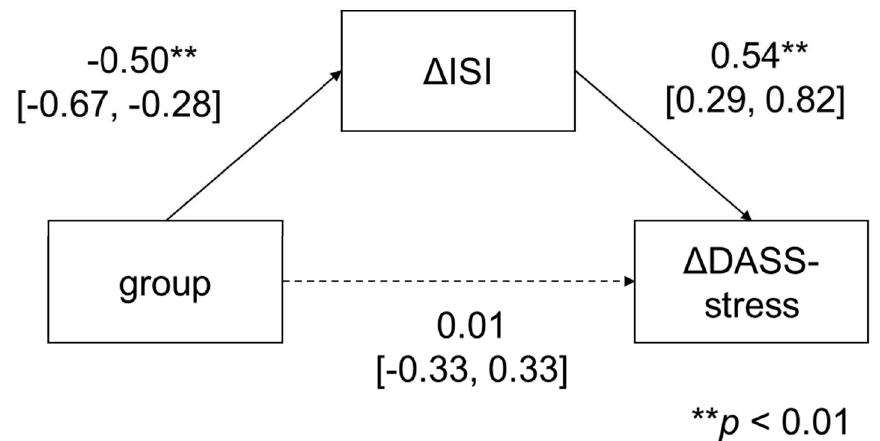
Figure 3. Mediation analysis of DASS-anxiety.